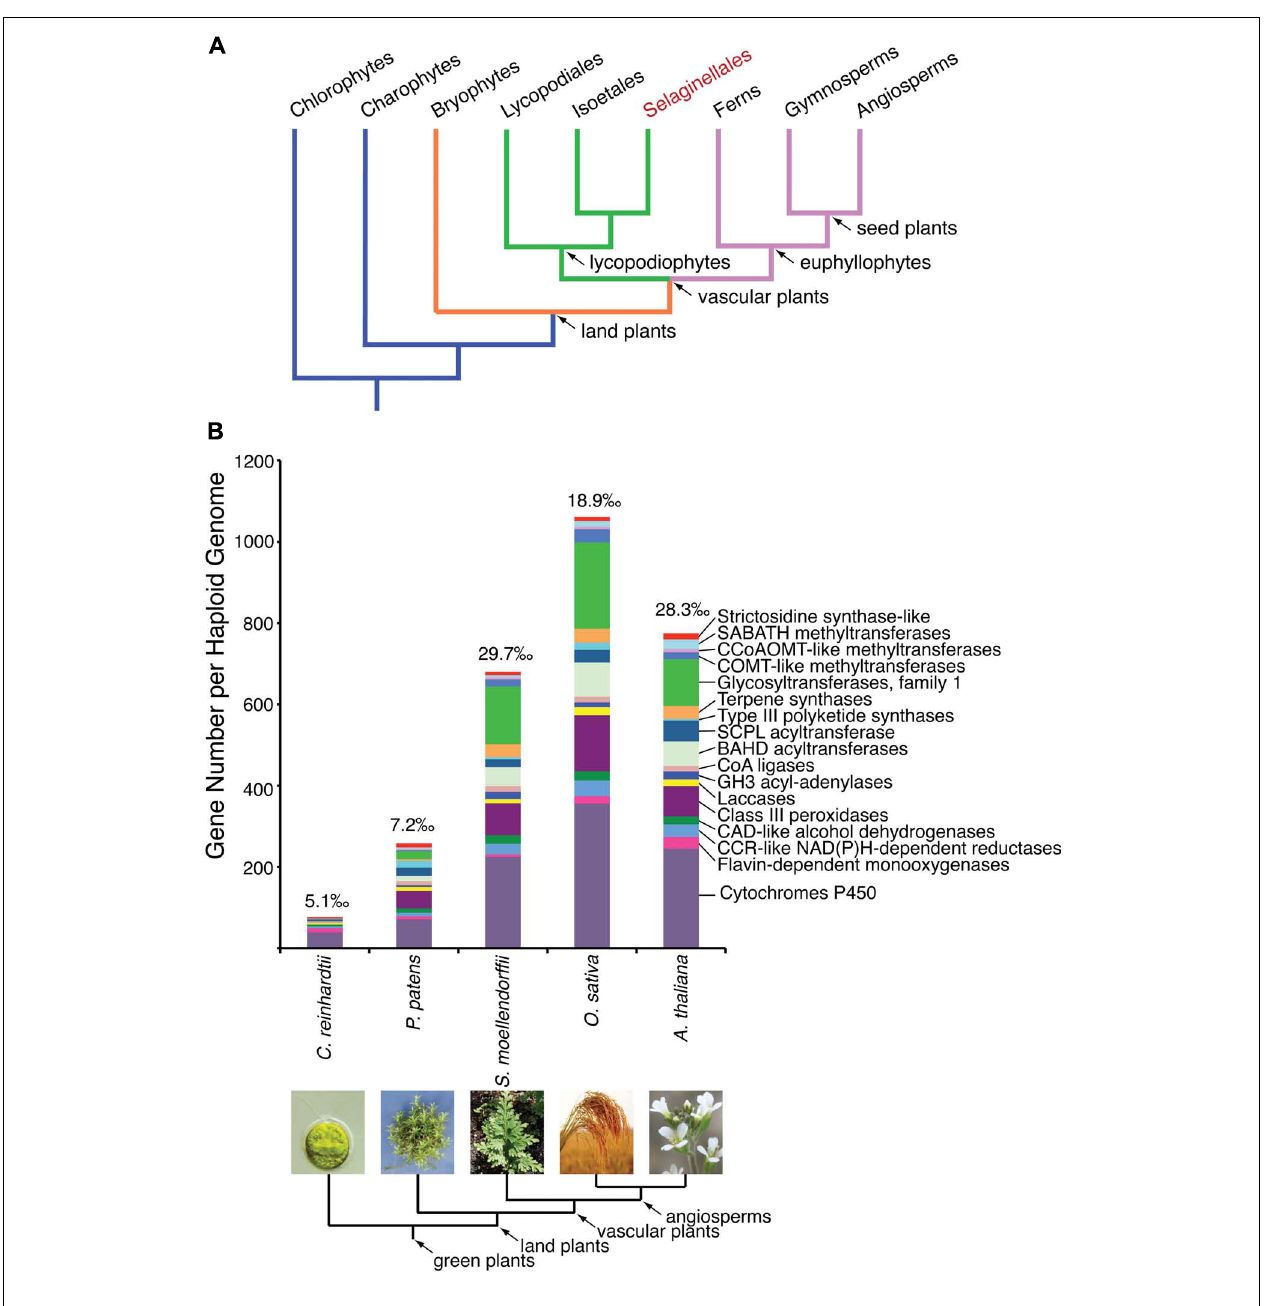
FIGURE 1 | (A) A simplified cladogram illustrating the phylogeny of the green plant lineage. Selaginella is the only genus under the order Selaginellales (highlighted in red), and represents an ancient lineage of vascular plants, lycopodiophytes. (B) A representative expansion of enzyme families implicated in specialized metabolism during plant evolution.The gene number for each enzyme family counted per haploid genome from five species